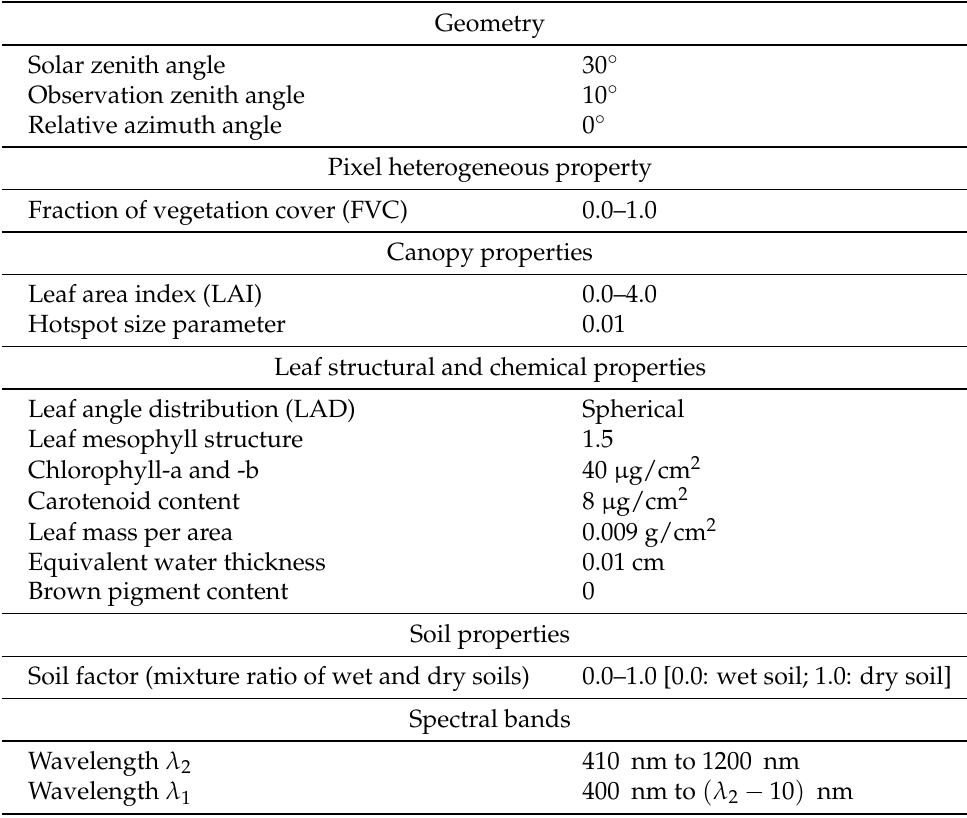
Table 1. Input parameters used in the numerical simulations